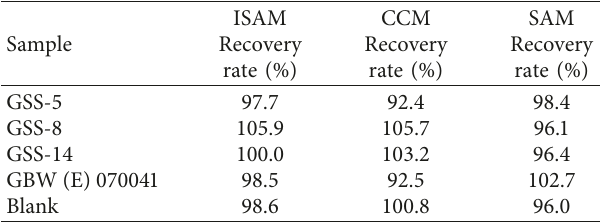
Table 8: Comparison of the recovery rate for the three